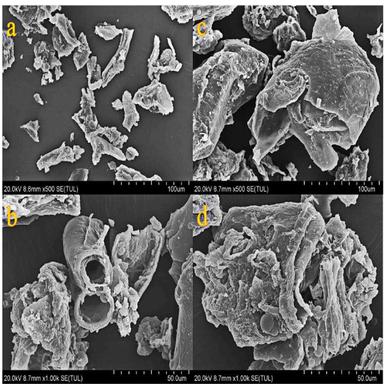
Scanning electron microscopic analysis of oil residue, UP-MAHD (a, b); HD (c, d).